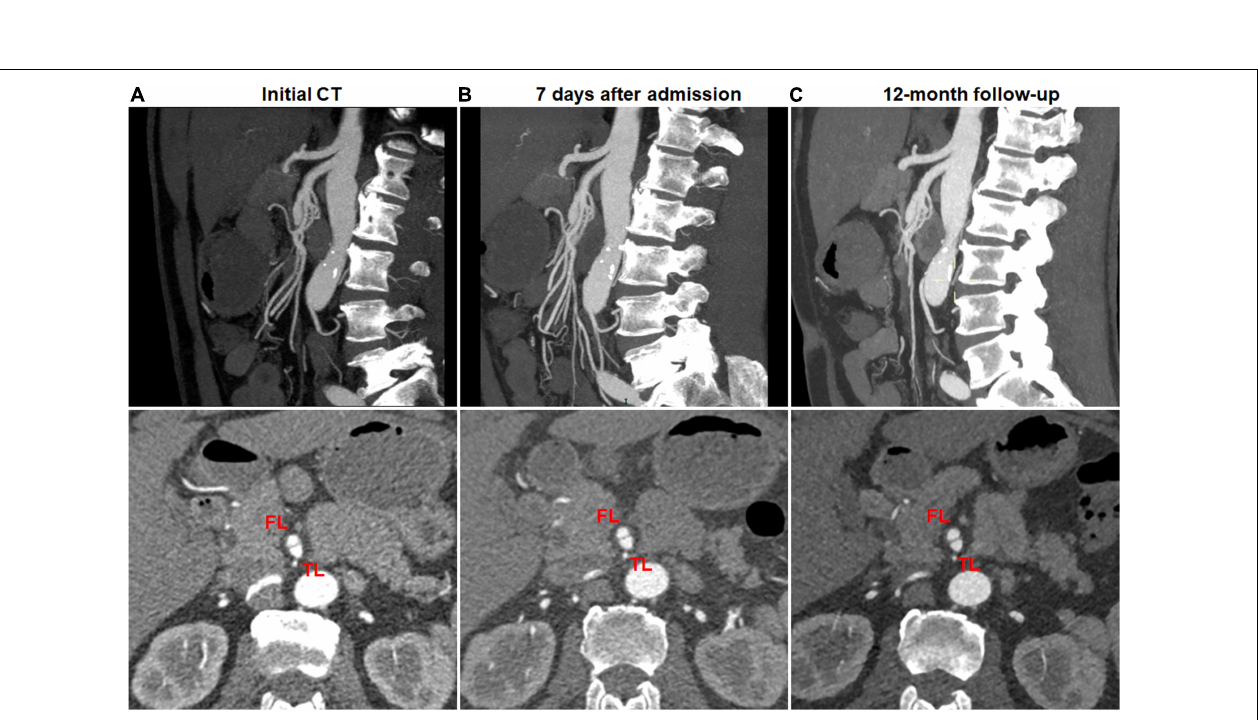
FIGURE 6 | No change of type II spontaneous isolated superior mesenteric artery dissection on follow-up computed tomography (CT) angiography. (A) Initial CT angiography showed the patent “cul-de-sac” shaped false lumen without re-entry in a 66-year-old woman. (B) One week after conservative management, true and false lumens were relatively stable. (C) The true lumen and blind-ending false lumen remained unchanged during the follow-up period of 12 months.